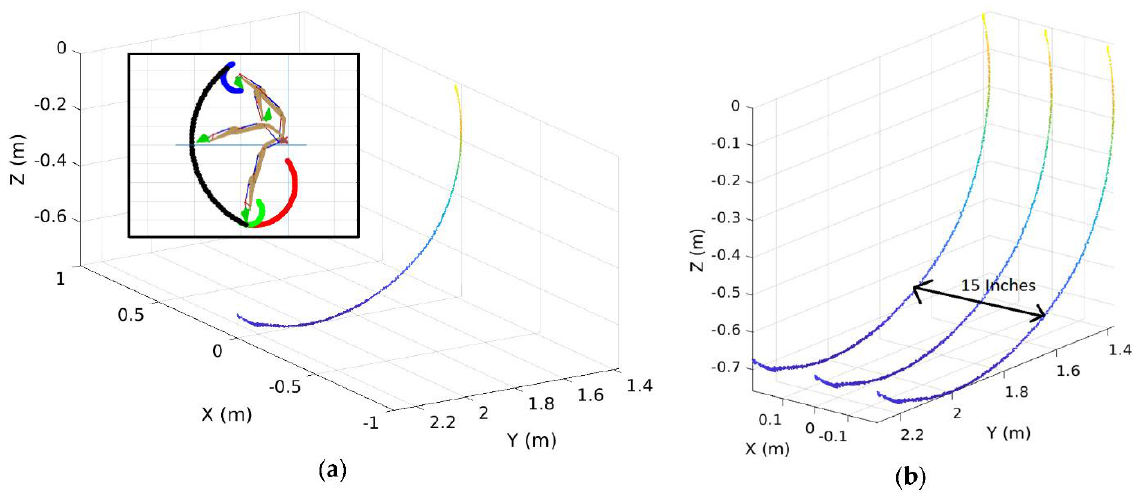
Figure 21. The identified bucket trajectory: ( a ) 2D bucket trajectory; ( b ) Converted 3D bucket trajectory by considering the bucket width.